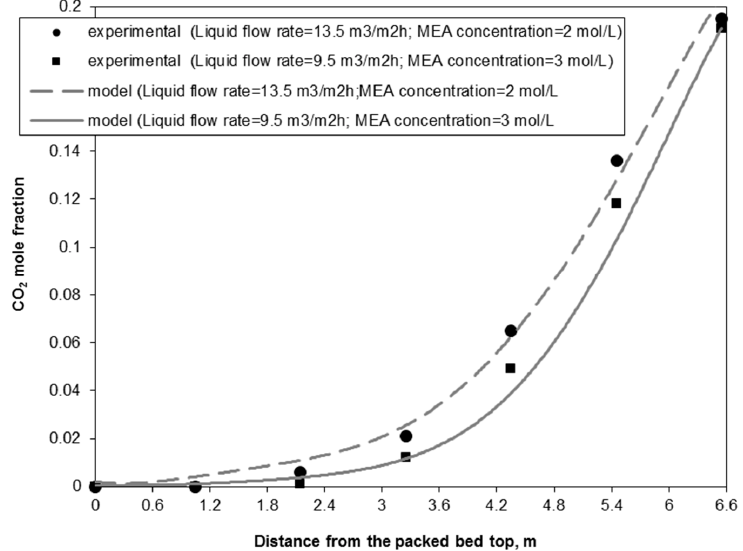
Figure 4. Experimental and theoretical axial CO 2 mole fraction profiles for CO 2 -MEA absorption in a countercurrent random packed-bed column (D = 0.1 m; H = 6.55 m; 19.5% CO 2 -MEA system; Gas flow